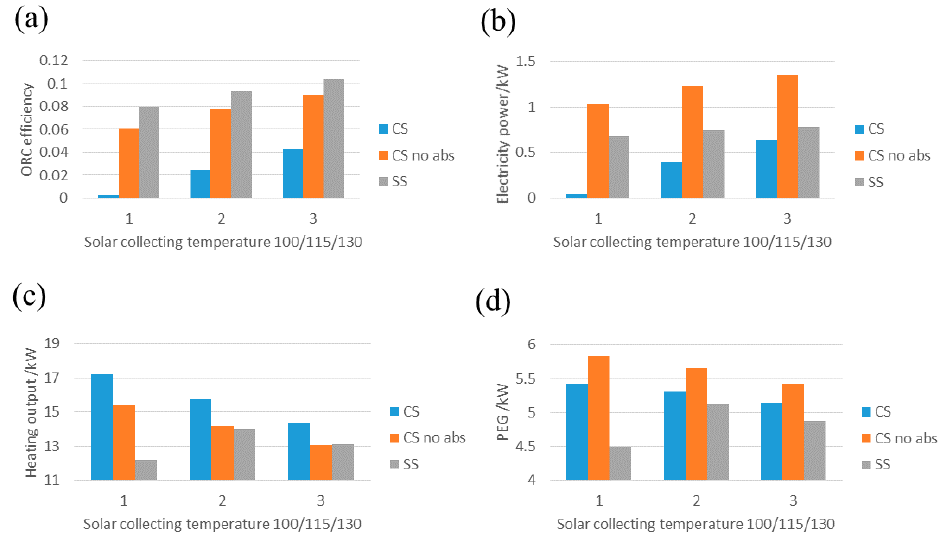
Figure 8. ( a ) ORC efficiency, ( b ) cooling output capacity, ( c ) electricity generation and ( d ) primary energy efficiency for the CCHP systems under different solar collecting temperature with R1233zd as ORC working fluids in heating mode.